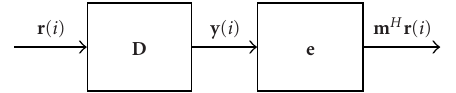
Figure 3: Two-stage linear receiver